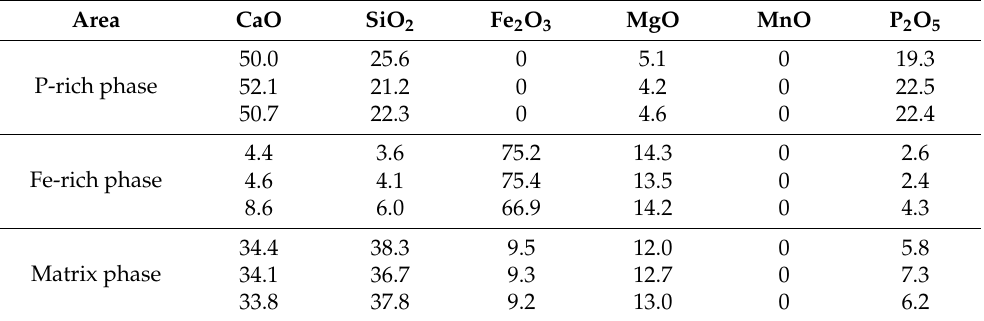
Table 2. Typical composition of each phase of high phosphorus steel slag